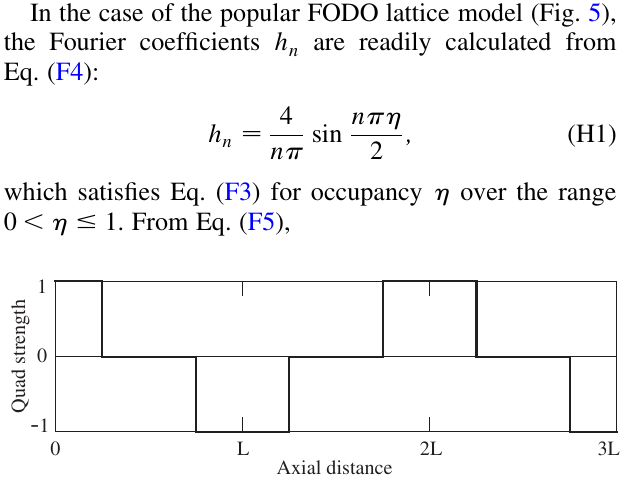
FIG. 5. Normalized quadrupole strength h (cid:1) z (cid:2) vs z for a FODO lattice having occupancy 0.5. The unit cell length is 2 L .